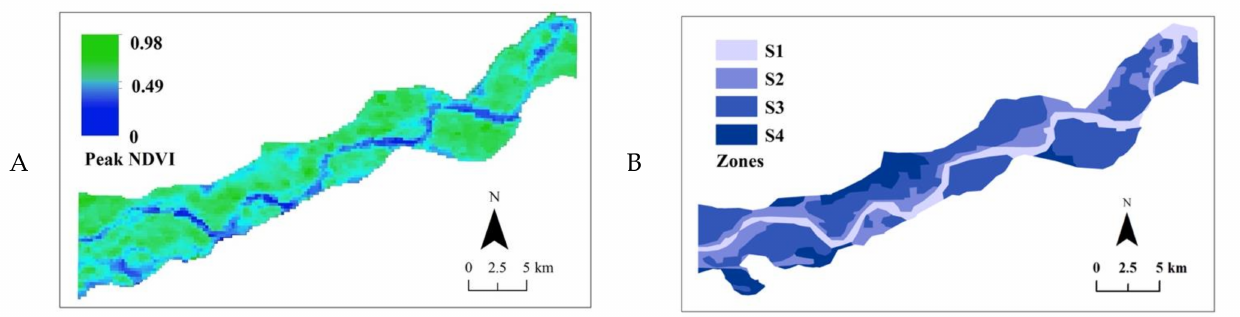
Figure 7. Spatiotemporal geomorphological dynamics of NDVI in the study area. ( A ) NDVI over time in different geomorphology units. The red line represents the static geomorphological area, and the blue line represents is the highly dynamic geomorphological area. ( B ) Box chart of the NDVI values in the highly dynamic and static geomorphological